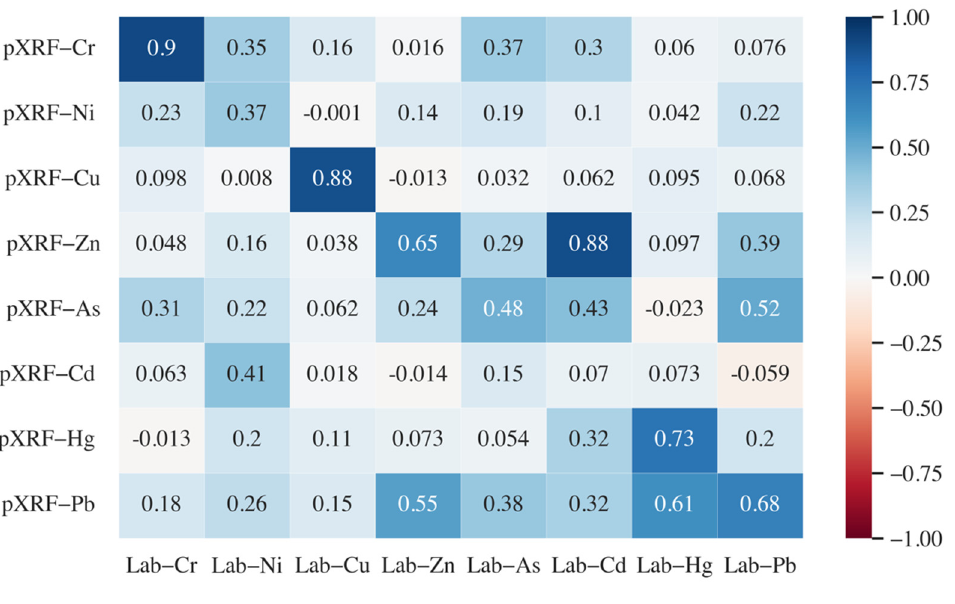
Figure 5. Pearson correlation between pXRF and laboratory value of samples in the whole dataset.